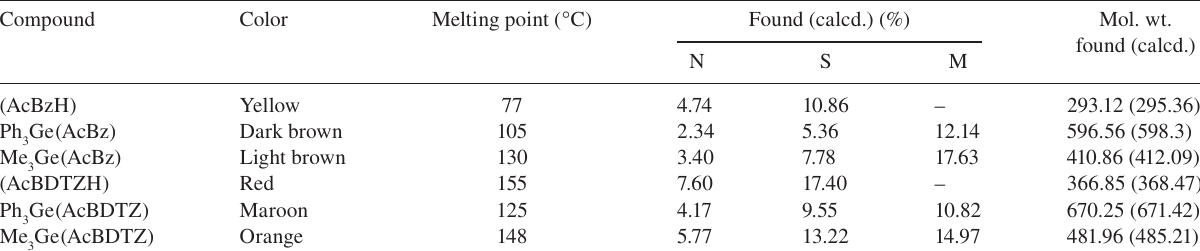
Table 5 Analytical data and physical properties of ligands and their metal complexes.